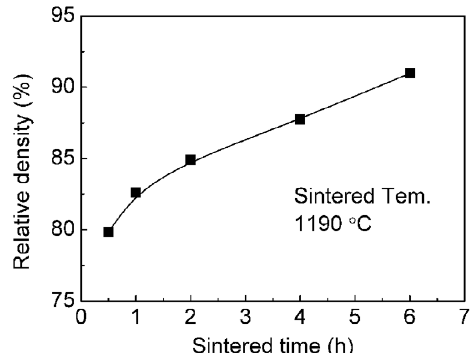
Figure 3. The relative densities of the ceramics are as a function of the sintering